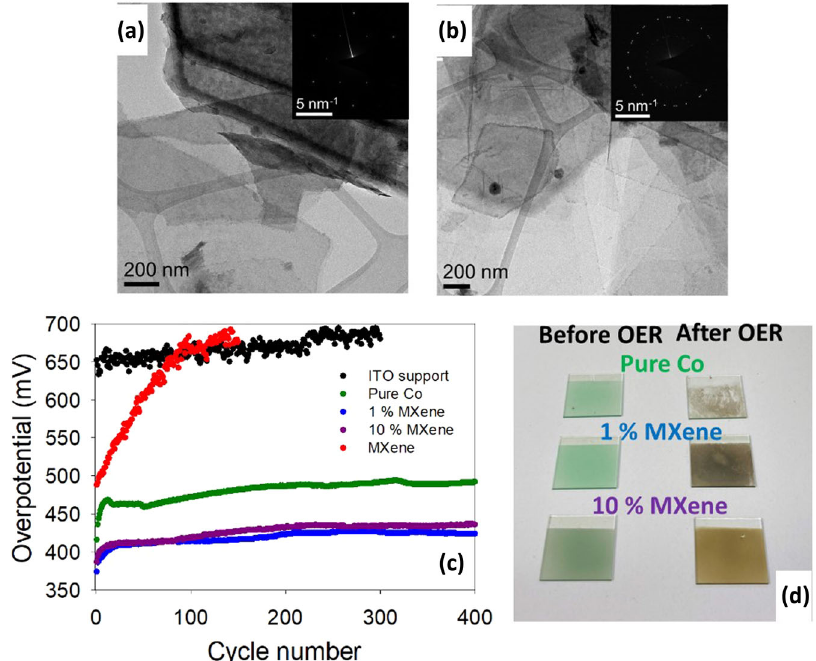
Fig. 7 OER stability study. a , b TEM images and corresponding SAED patterns for the 10% MXene before OER. c Effect of multi-cycling into and out of the OER region for the ITO support, pure Co, 1% MXene, 10% MXene and the pure MXene materials. d Photo of the pure Co, 1% MXene and 10% MXene catalysts before and after